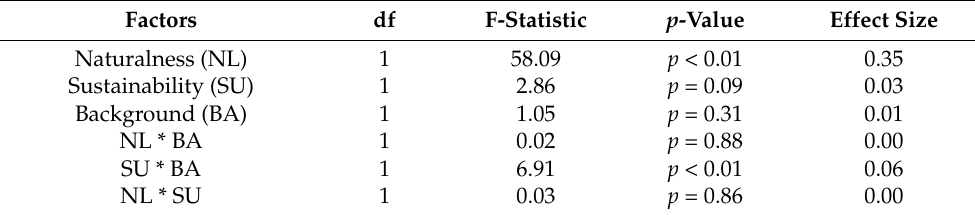
Table 3. Summary of the main effects and interactions of perceived